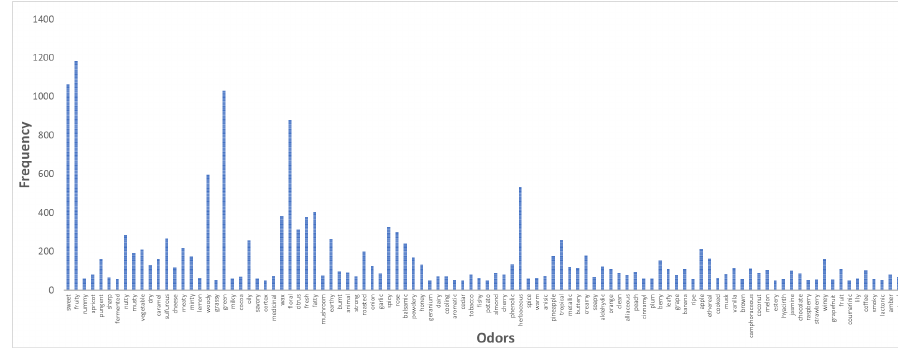
Figure 2. Frequency distribution of different odor descriptors.